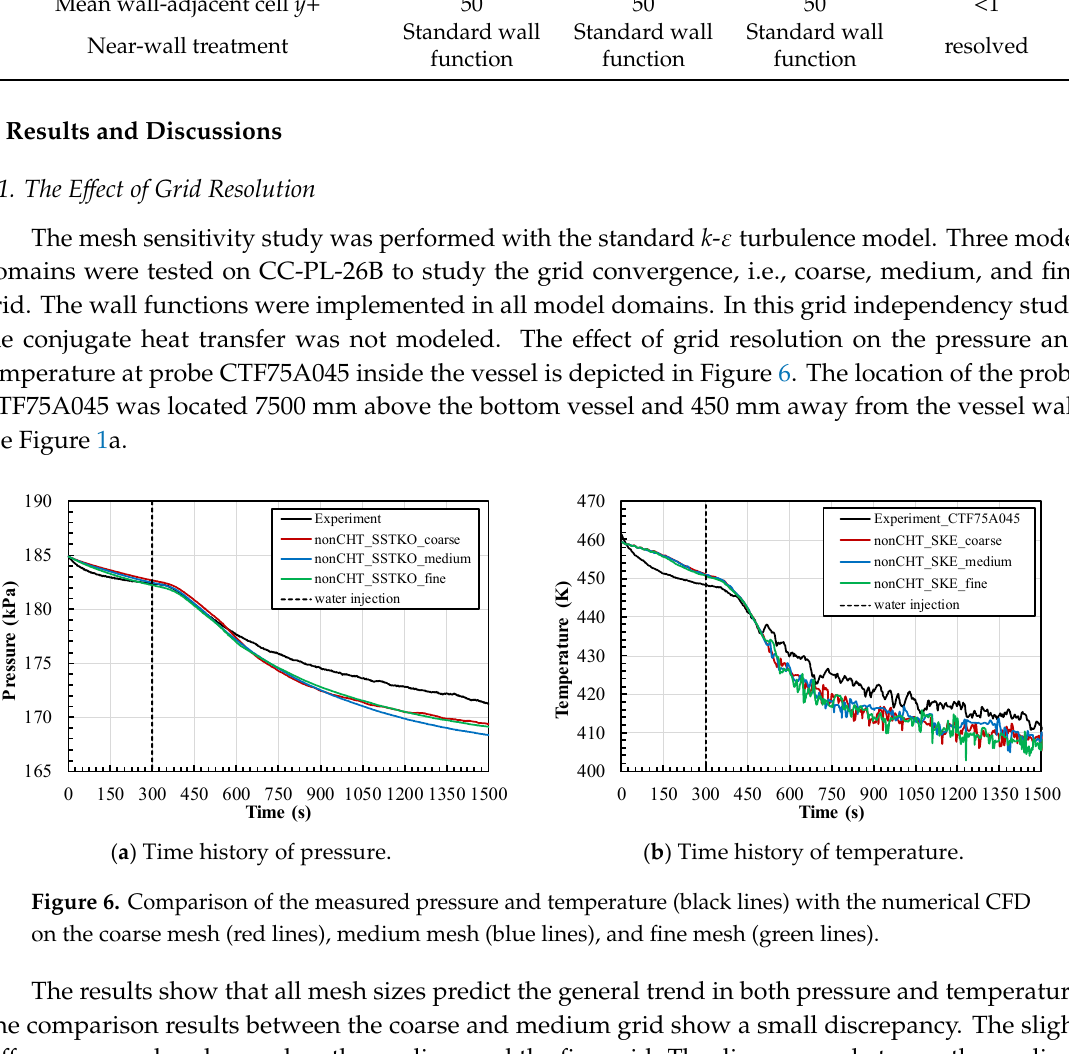
Figure 7. Comparison of the measured pressure and temperature (black lines) with the numerical CFD on the y + = 1 mesh (green line), medium mesh with the standard k - ε turbulence model (red lines), and medium mesh with the SST k - ω turbulence model (blue lines). As shown in Figure 7a, the predicted pressure by means of the high Reynolds model with standard k-ε and k-ω SST (nonCHT_SKE and nonCHT_SSTKO) agrees well, and they are both close to the experimental results, particularly before t = 500 s. The pressure prediction by a low Reynolds k-ε Launder–Sharma model (nonCHT_LS), however, is underestimated, particularly before t = 600 s. It can be observed in Figure 7a that that the standard k - ε turbulence model shows a lower pressure compared with the other models, particularly between t = 500 s and t = 850 s. It might be due to the transition from the laminar natural convection to the turbulent natural convection. As a consequence, the turbulence model with a wall function overestimates the turbulent kinetic energy near the wall since the k - ε turbulence model leads to an overprediction of the turbulent length scale in the flows with adverse pressure gradients, resulting in the overestimation of the heat transfer rates. Nevertheless, after t = 900 s, the predicted pressure by means of the standard k-ε and k-ω SST turbulence model shows a small discrepancy compared to a low Reynolds k-ε Launder–Sharma model. Their mean deviation is about 0.7%. The predicted pressure and temperature by means of the k-ω SST turbulence model shows a better performance than the standard k-ε turbulence model on the unsteady natural convection inside the large containment vessel.